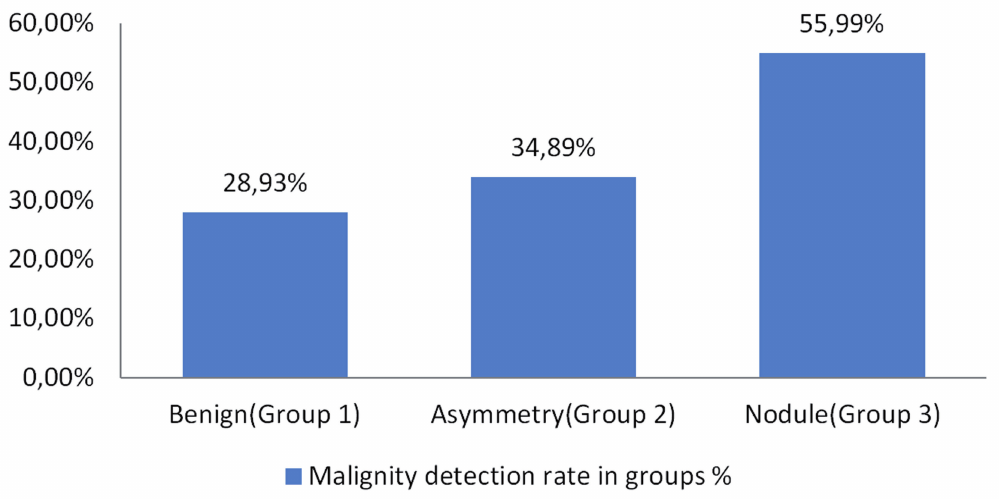
figure 1 - Malignancy detection rate of DRE